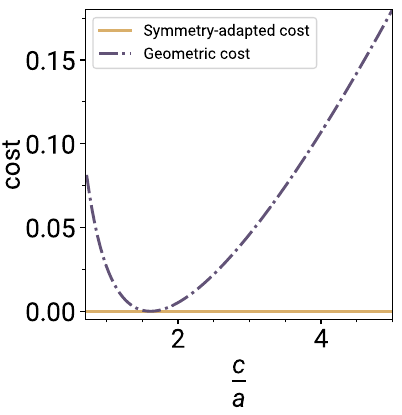
Fig. 3 Geometric cost versus symmetry-adapted cost. A compar- ison of the symmetry-adapted cost with the geometric cost when mapping an hcp crystal structure with varying c/a ratio onto a reference hcp crystal with a c/a ratio of ≈ 1.6.